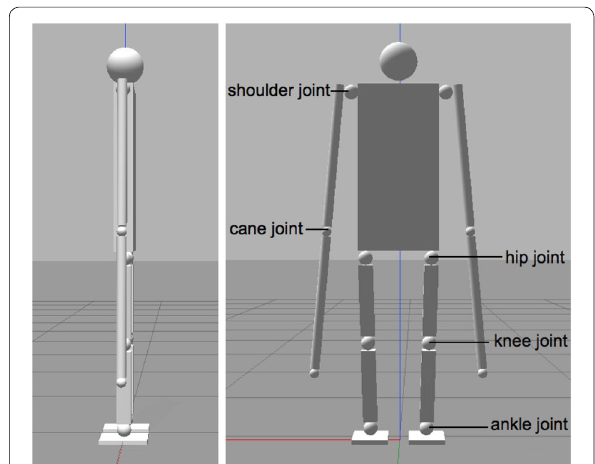
Fig. 6 Walking robot replacing a patient for preliminary study